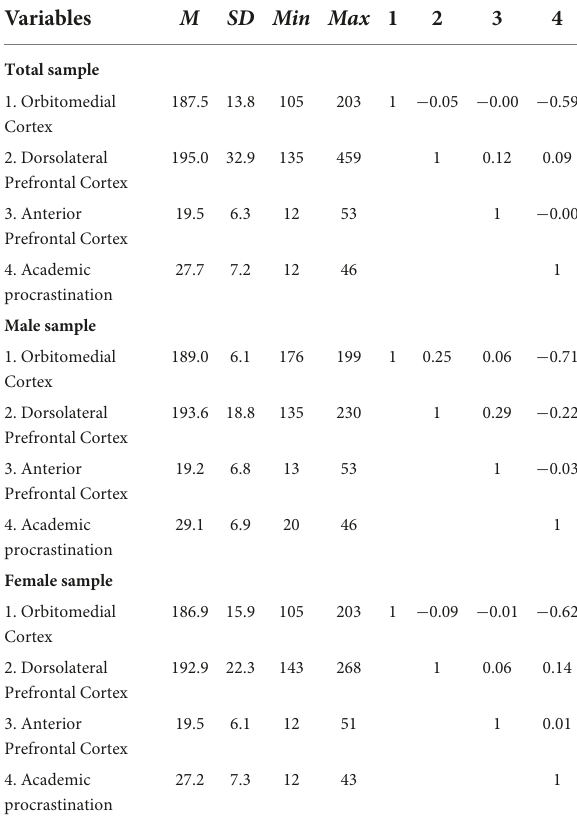
TABLE 2 Descriptive analysis and correlation between